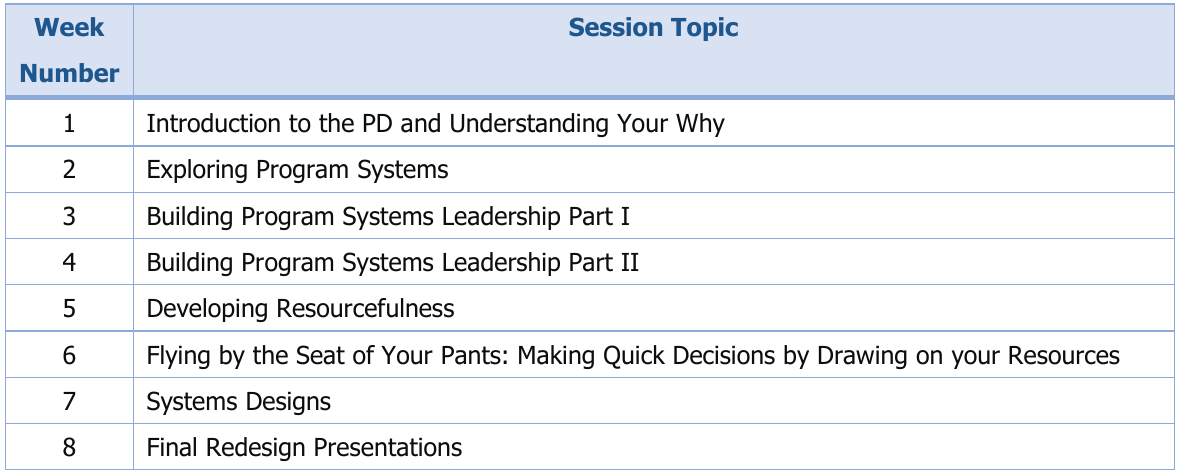
Table 1. Professional Development Session